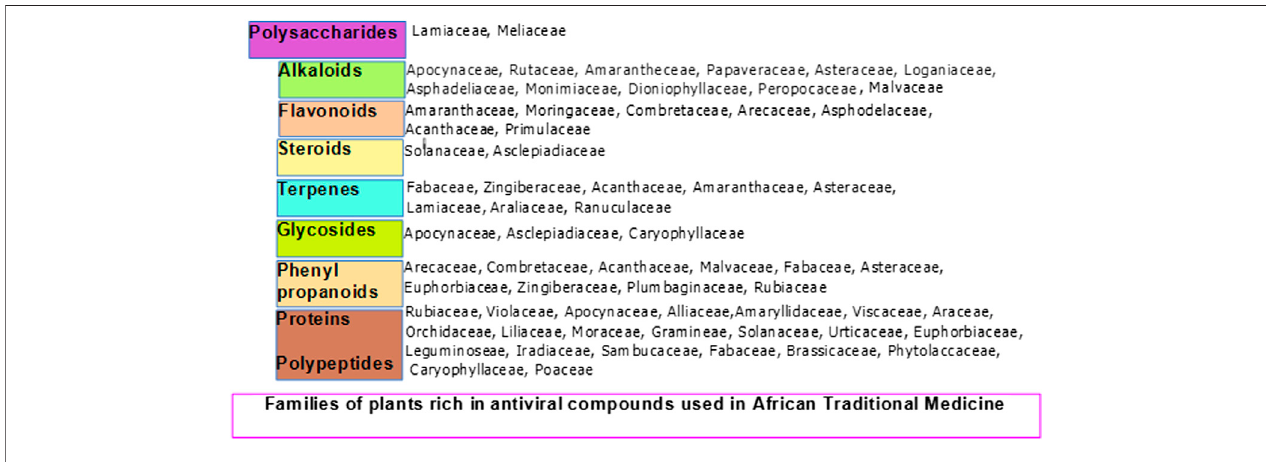
FIGURE 4 | Family of Plants endemic to Africa expressing and accumulating antiviral primary and secondary metabolites.